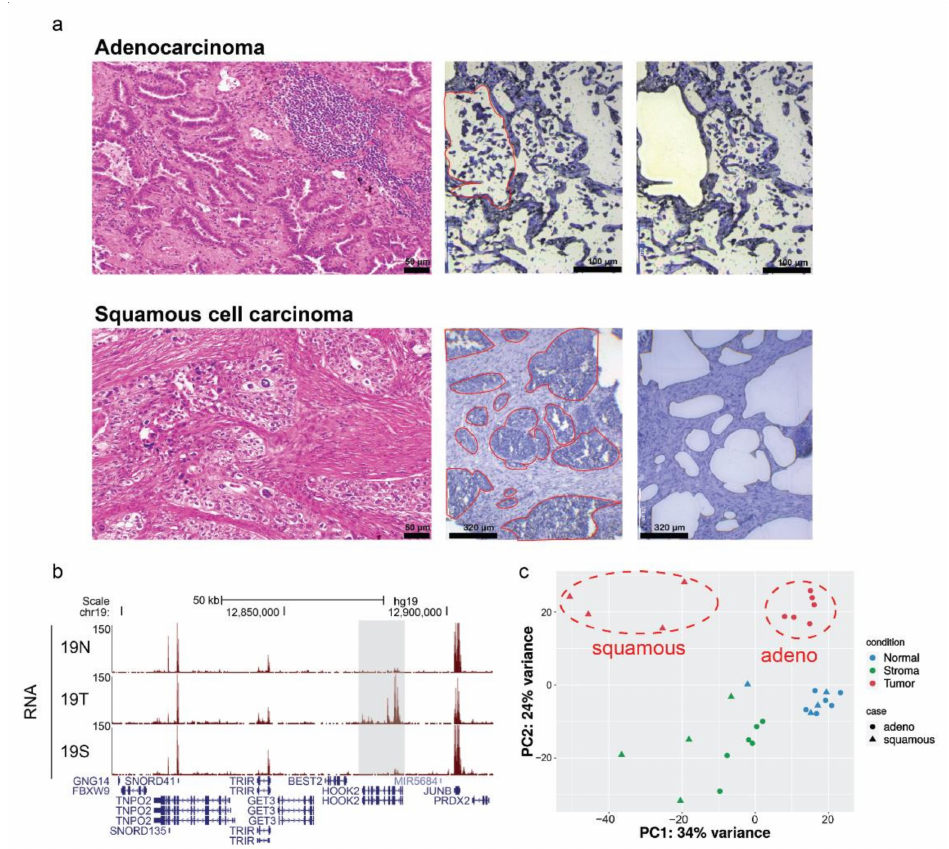
Figure 1. ( a ) Representative images of specimens undergoing laser microdissection (LMD). The examples of target areas are outlined with red line marks. The two lung cancer subtypes are adenocarcinoma (top row) and squamous cell carcinoma (bottom row). Scale Bar: 50 µ m, 100 µ m and 320 µ m. ( b ) Representative view of RNA-Seq visualization captured using the UCSC genome browser. Case 19 is shown including the normal sample (19N), tumor sample (19T), and stroma sample (19S). The tumor-specific RNA-Seq signal is highlighted in the grey box. ( c ) PCA plot generated using the normalized counts (DESeq2 Methods). Lung tumor subtypes were separately clustered (red dotted